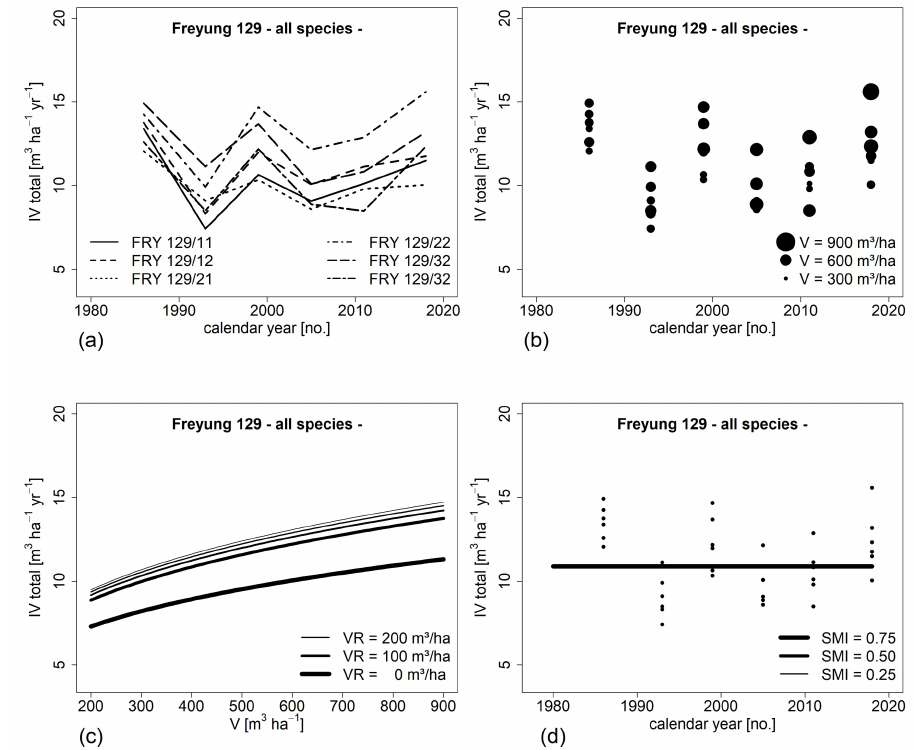
Figure 4. Stand volume growth in dependence on ( a ) calendar year, ( b ) standing volume, ( c ) standing volume and removal of standing volume by selection cutting at the beginning of the respective growth period, ( d ) Soil Moisture Index. The curves in ( c , d ) are based on Models 2 and 3 (see Table 4); we inserted mean values for the stand stem volume, V, in case of Model 3. Note, that in ( d ) lines for different SMI are on the same level as it had no significant effect (see Table